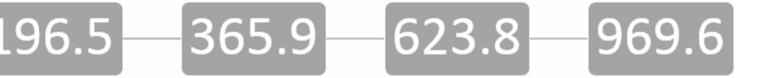
Figure 5. Peak demand (GW) across India for each of the four epochs (2020–2029, 2030–2039, 2040–2049,